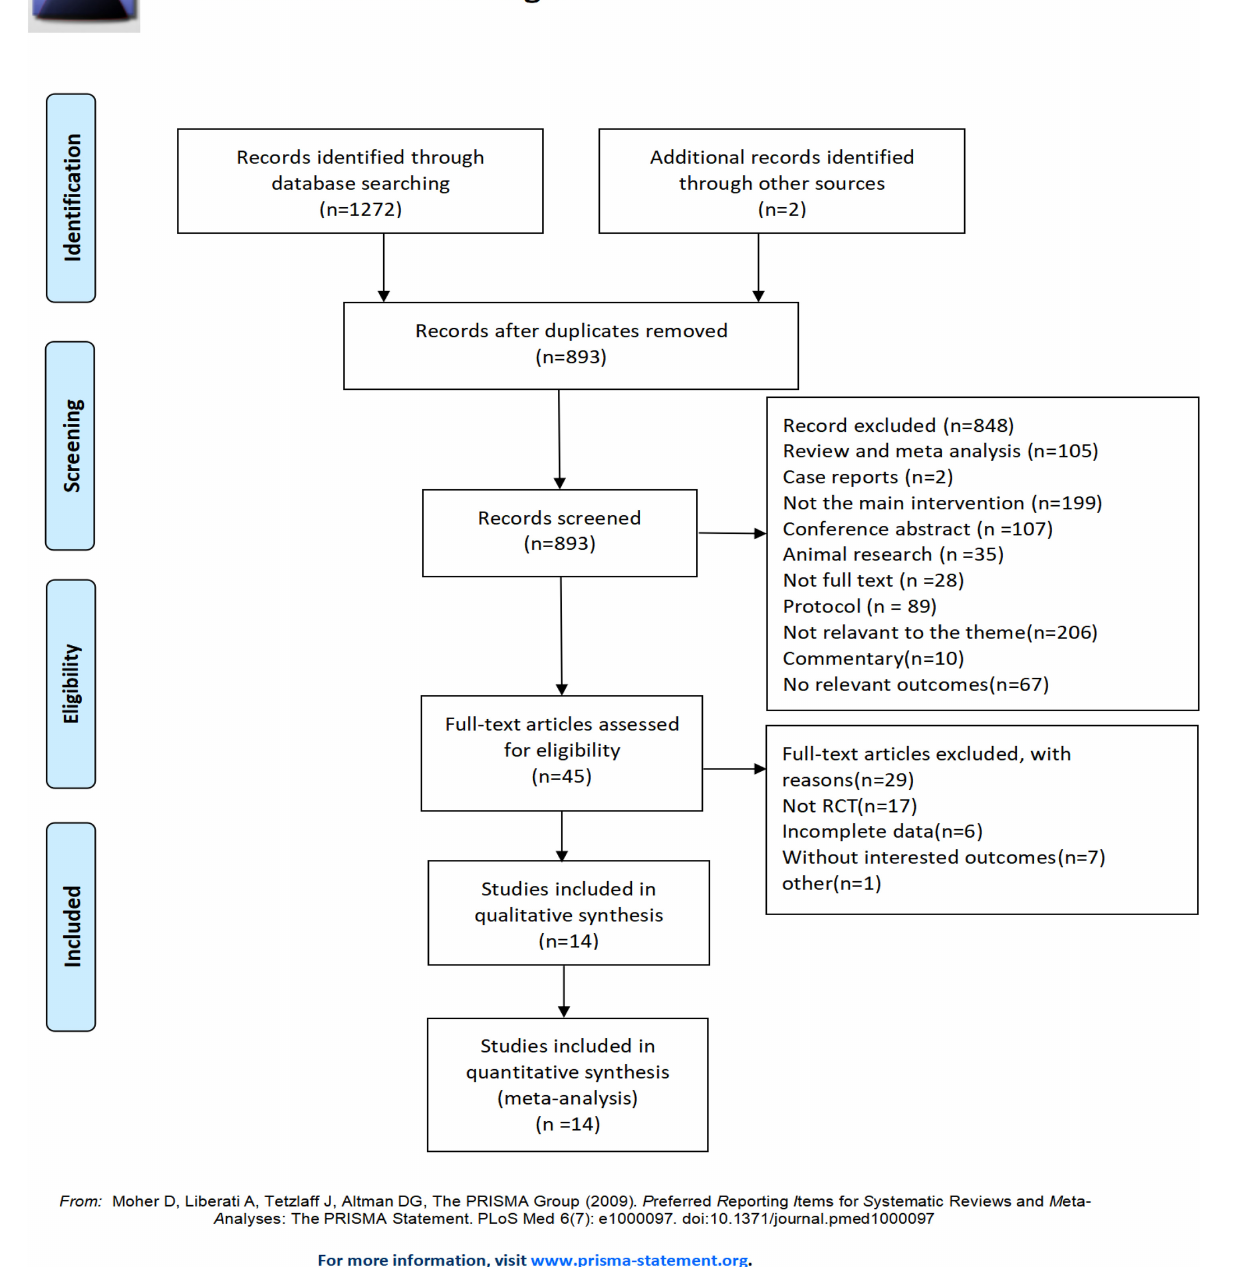
FIGURE 1 | Flow of the trial selection